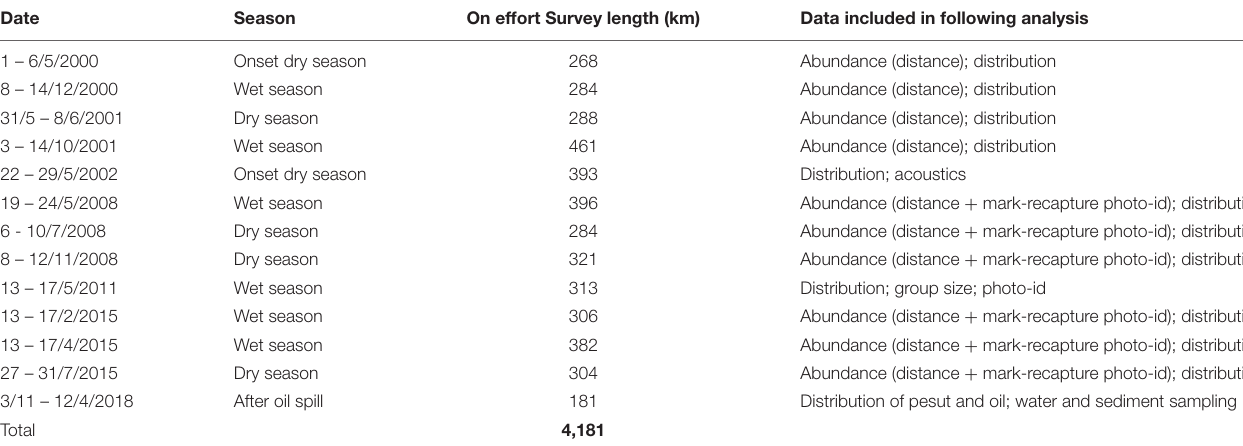
TABLE 1 | Survey periods, boat-based survey effort and data